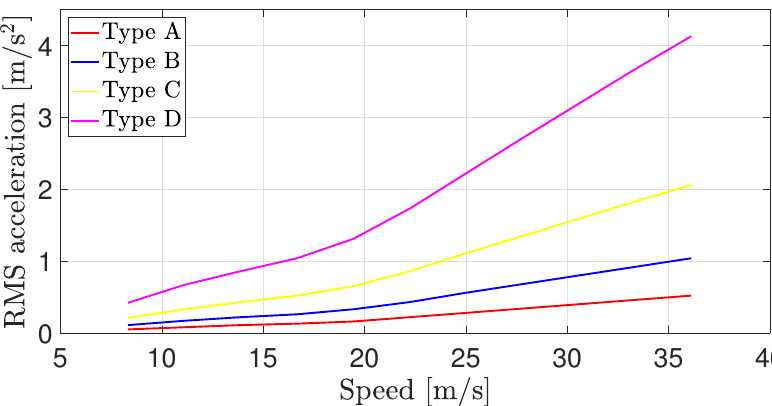
Figure 7. Comfort evaluation for different road types.